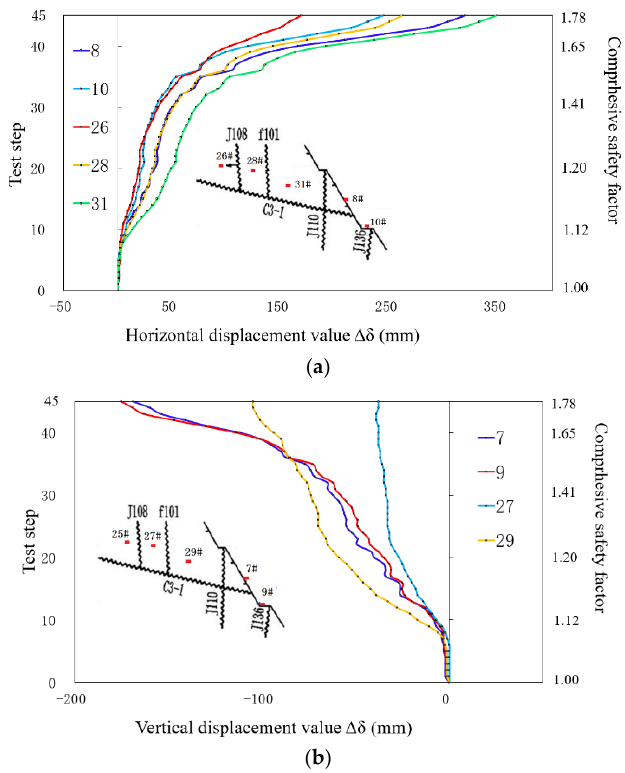
Figure 9. Typical curve of slope surface displacement (monitoring points near C 3-1 ). ( a ) Horizontal displacement; ( b ) vertical displacement. displacement; ( b ) vertical